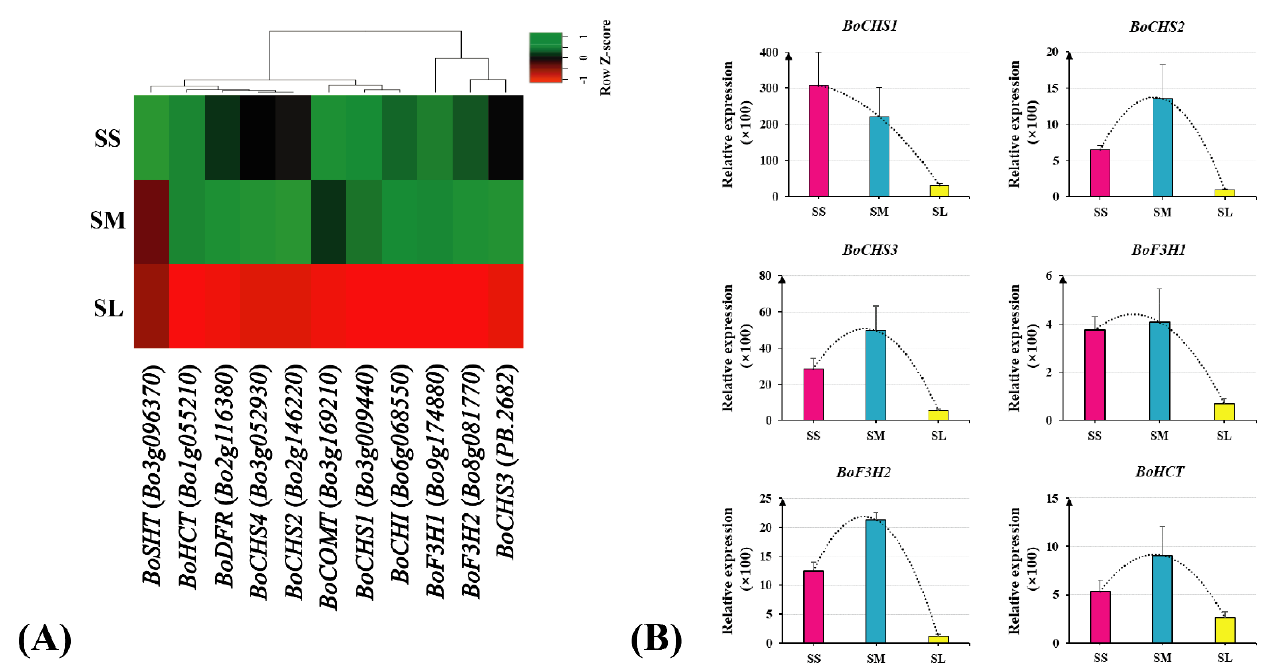
Figure 6. Cluster analysis and qRT−PCR validation of candidate genes related in the flavonoid biosynthesis pathway. ( A ) Heatmap of candidate gene expression profile. ( B ) qRT−PCR analysis of candidate genes related to the flavonoid biosynthesis pathway.